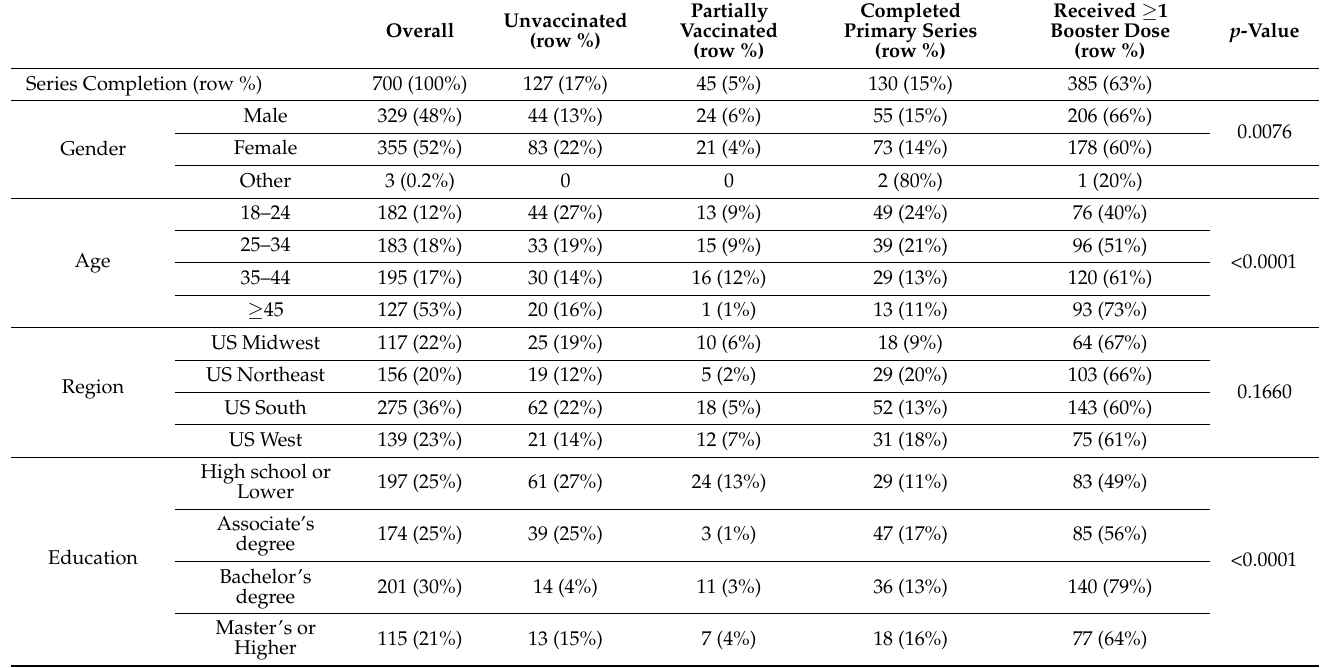
Table 1. Vaccination completeness, and its distribution by demographic characteristics, race/ethnicity, religion, and political affiliation, stratified by vaccination completeness, United States, August